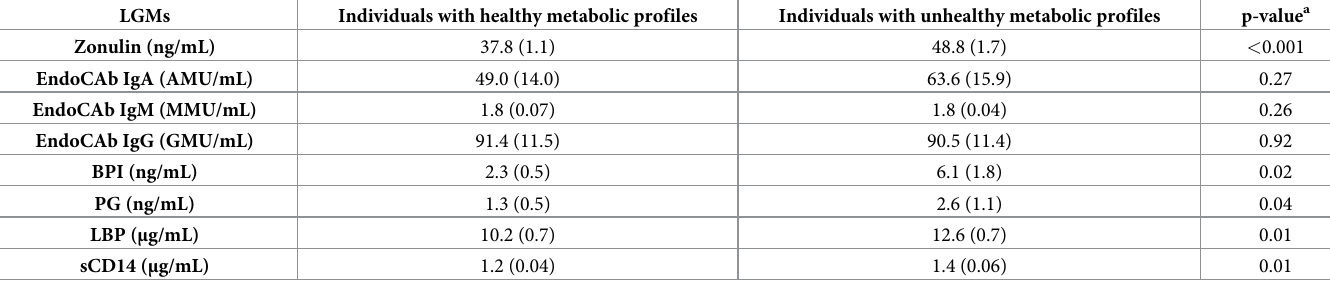
LGMs with a potential direct or indirect relation to impairment in intestinal integrity and/or bacterial translocation were selected and measured in serum or plasma samples obtained from all 80 individuals. Table 2 summarizes the differences between individuals with healthy and unhealthy metabolic profiles for all measured markers. Those with unhealthy metabolic pro- files exhibited significantly higher zonulin, LBP, sCD14, PG, and BPI levels. Data on metabolic characteristics and LGM levels are provided separately for sex and age ( < 54 and � 54 years) in S2 and S3 Tables. Table 2. LGM levels (mean ± SE) in individuals with healthy (n = 40) and unhealthy (n = 40) metabolic profiles in the pilot study.